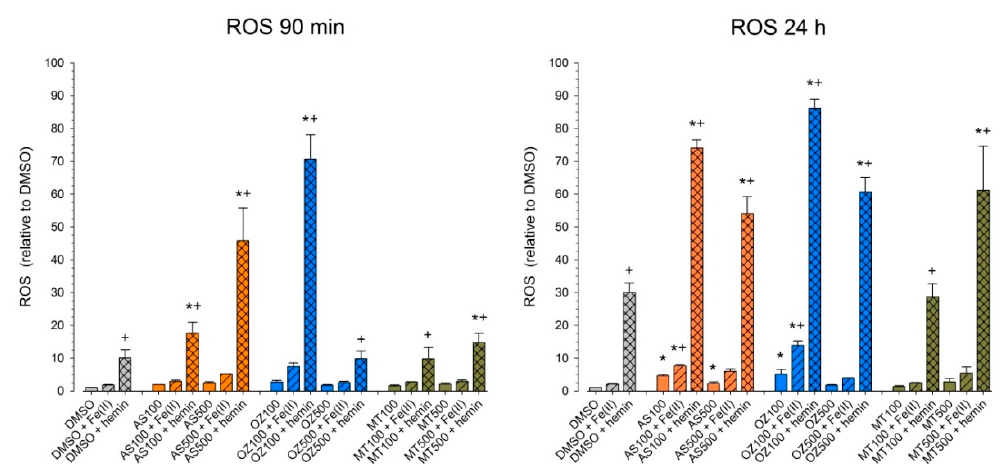
Figure 5. Effect of Fe 2+ and hemin on cellular generation of reactive oxygen species (ROS). HepG2 cells were treated with AS, OZ78 or MT04 (100 or 500 µM) alone or in the presence of Fe 2+ or hemin. ROS abundance was measured using dichlorodihydrofluorescein diacetate (DCF-DA) after 90 min and 24 h. Results are expressed as mean ± STD of four independent experiments carried out in triplicates. * p < 0.05 vs. control incubation containing DMSO, DMSO + Fe 2+ or DMSO + hemin. + p < 0.05 versus the respective incubation containing only the investigated compound but no addition (Fe 2+ or hemin).